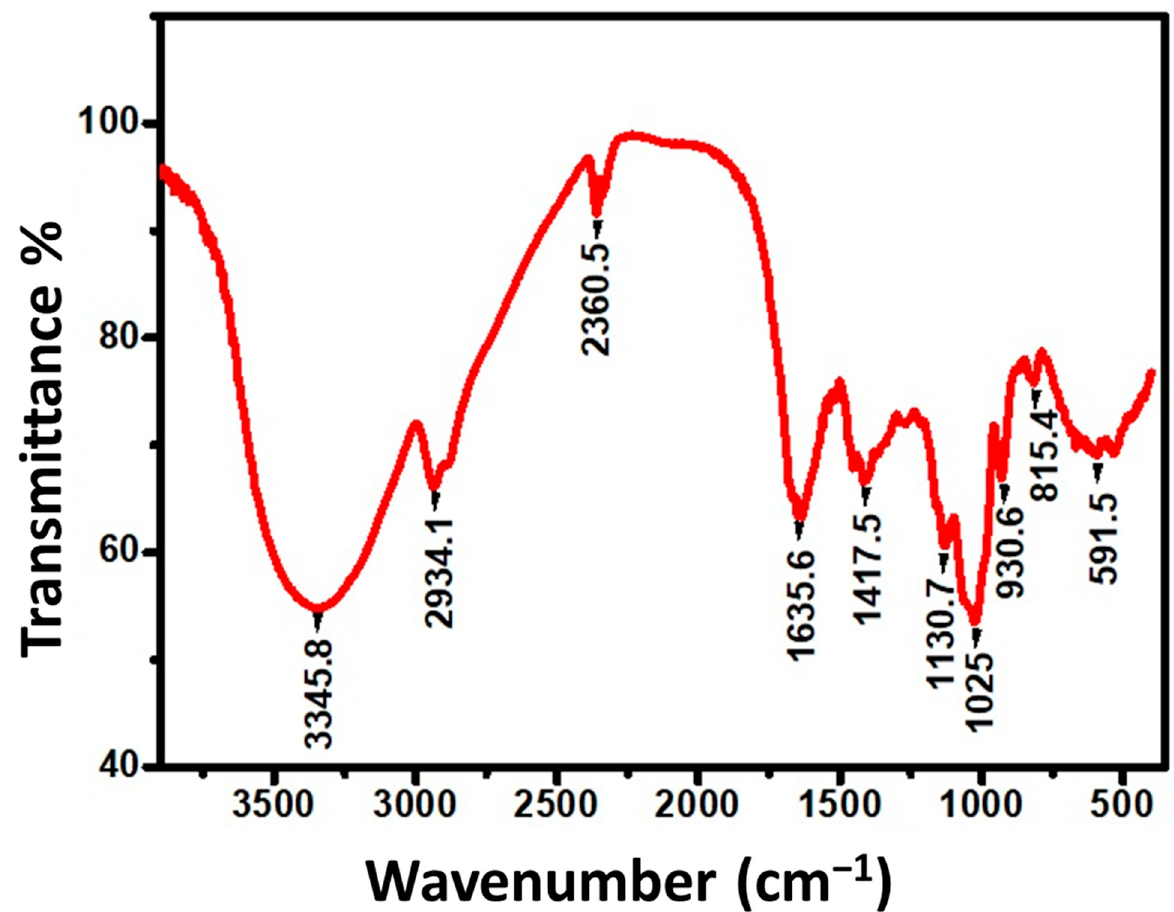
Figure 5. FTIR spectrum of nanoparticles from garlic extract.